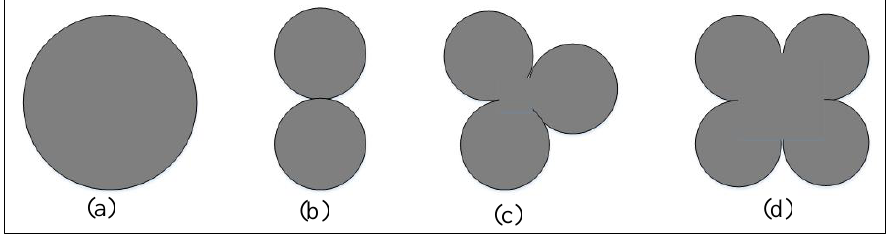
Figure 6. An image objects composed by one ( a ), two ( b ), three ( c ), or four ( d ) identical crown. Step 4.2: Combine the fine layer and the coarse layer. The two previously sifted layers are combined into a new layer using a logic ‘OR’ operation (Figure 5d), and the latter is further refined with reference to the roundness of objects. In the re-shifted combined layer (Figure 5e), only treetops are retained, whereas slices of tree clusters are eliminated.